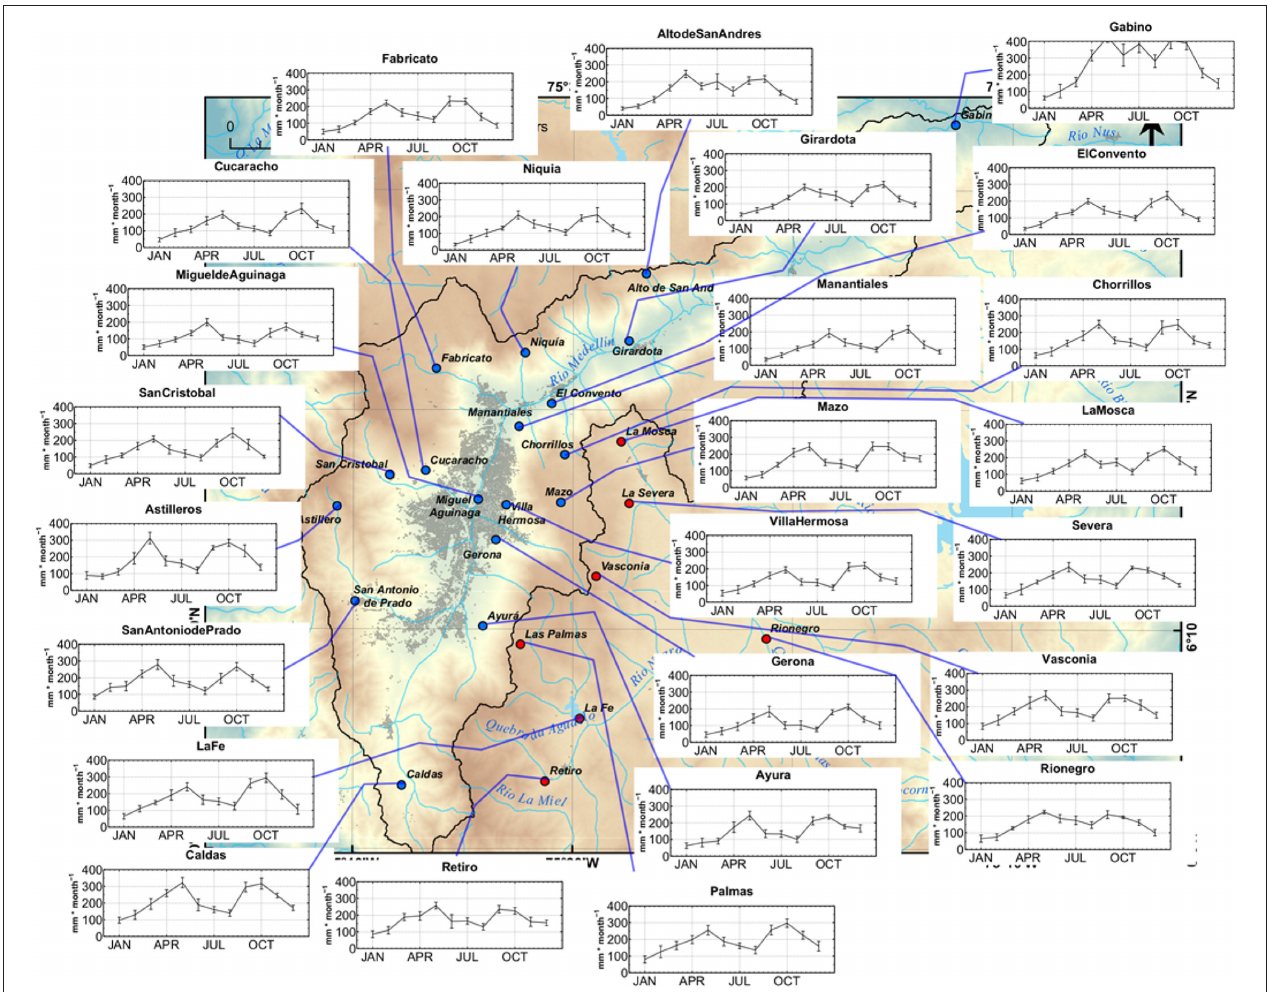
FIGURE 2 | Long-term mean annual cycle of rainfall at rain-gauges included in the study. Error bars on all panels represent the standard error of the mean. Blue (red) points in the map represent the raingauges located on the Aburrá Valley (San Nicolás Plateau).